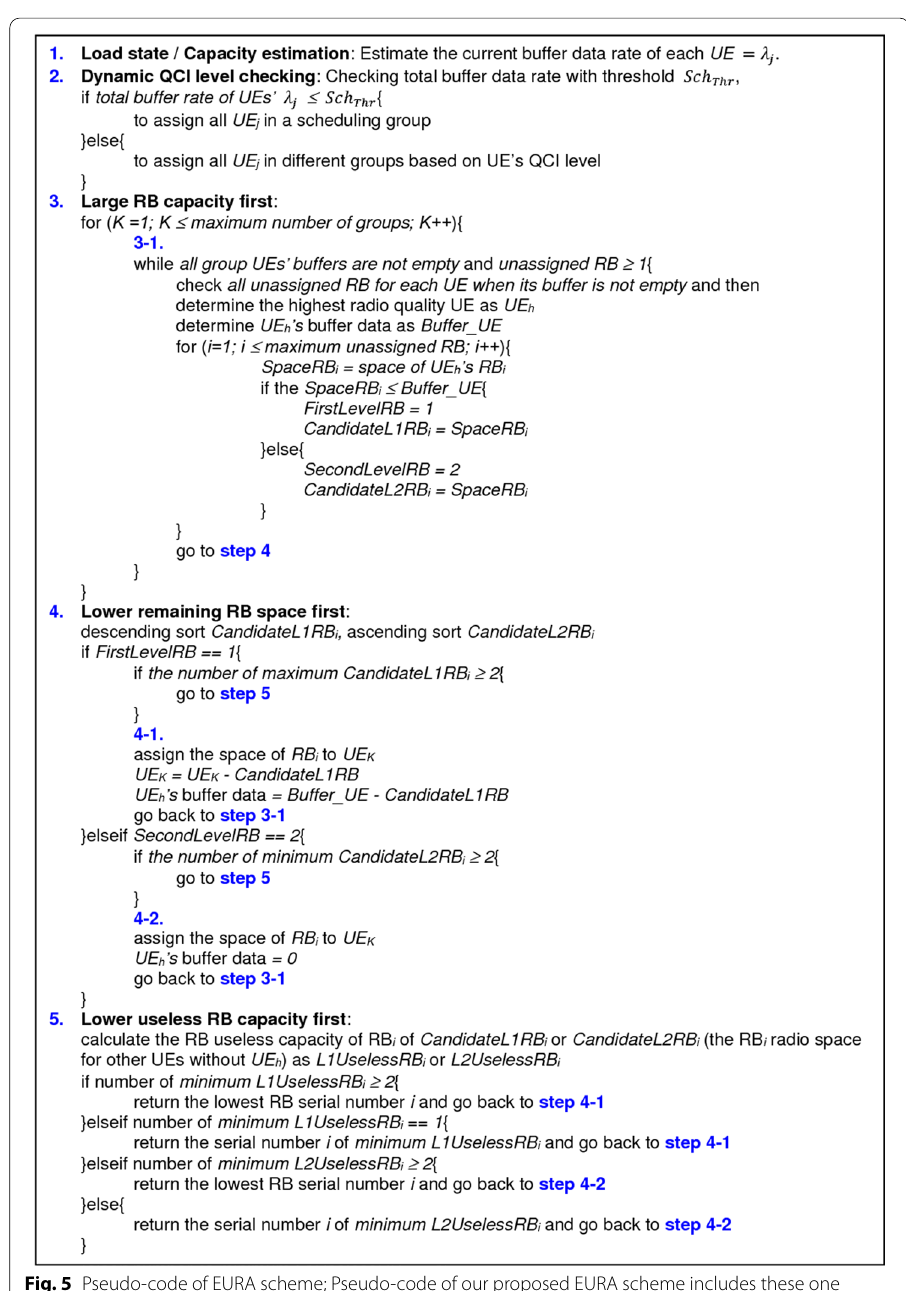
Fig. 5 Pseudo‑code of EURA scheme; Pseudo‑code of our proposed EURA scheme includes these one checking policy and three novel